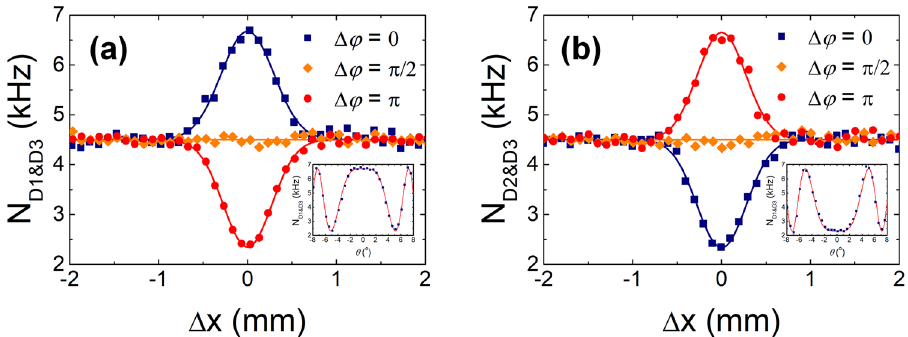
Figure 10. Experimental results relating to the two-photon interference of spatially separated weak coherent pulses. Coincidences are measured with two detectors ( a ) D1 and D3, and ( b ) D2 and D3 as functions of (cid:31) x 1 (cid:31) x 2 path-length difference (cid:31) x for two spatially separated input photons. Coincidence fringes for | = | + each combination of the two detectors are obtained with a relative phase shift between the two two-photon amplitudes. Insets in ( a ) and ( b ) indicate the coincidence counts measured as functions of the rotation angle of the thin glass plate, which introduces an additional relative phase shift between the two interfering